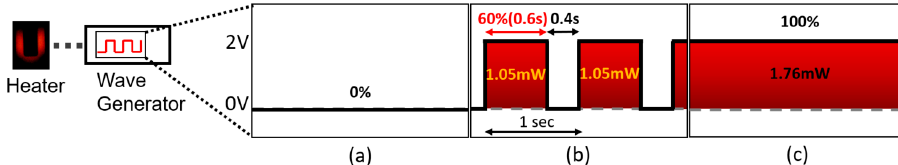
Figure 3. Schematic view of connection with microheater and power wave generator. ( a ) A 0% duty cycle means non-heating. ( b ) A 60% duty cycle of oscillation with 2 V shows 1.05-mW energy consumption. ( c ) Full duty cycle (continuous heating) generates 1.76 mW of energy consumption.